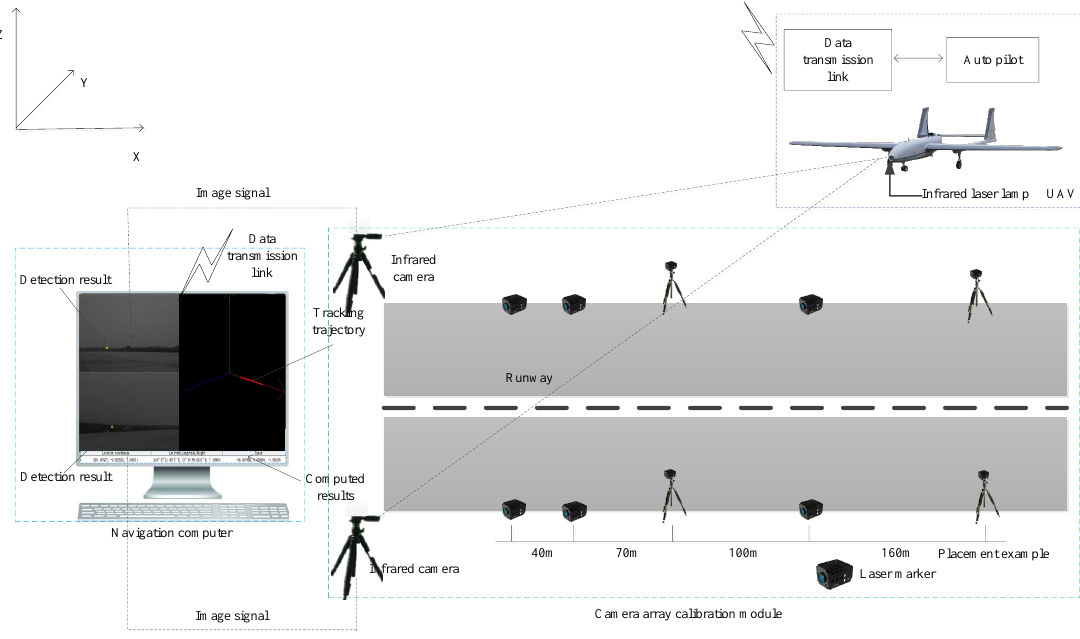
Figure 1. Infrared camera array